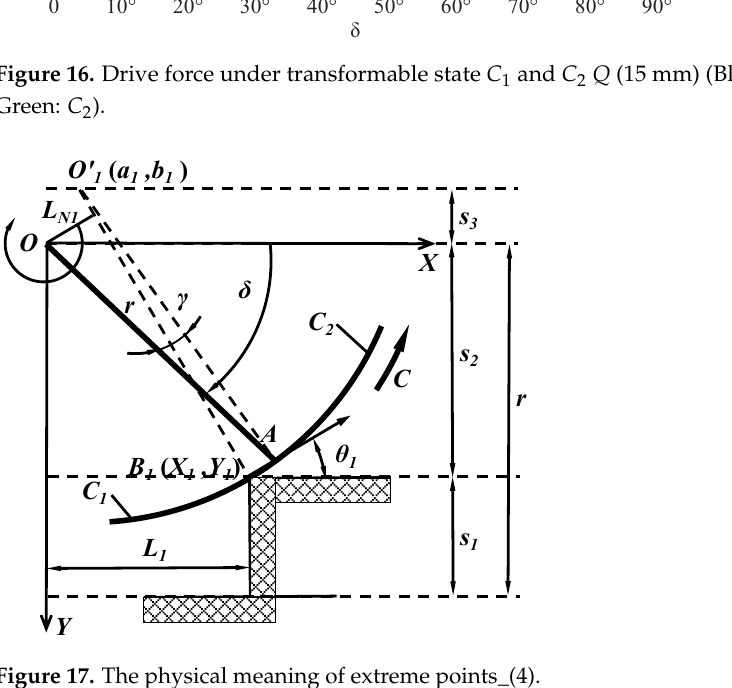
Figure 17. The physical meaning of extreme points_(4).